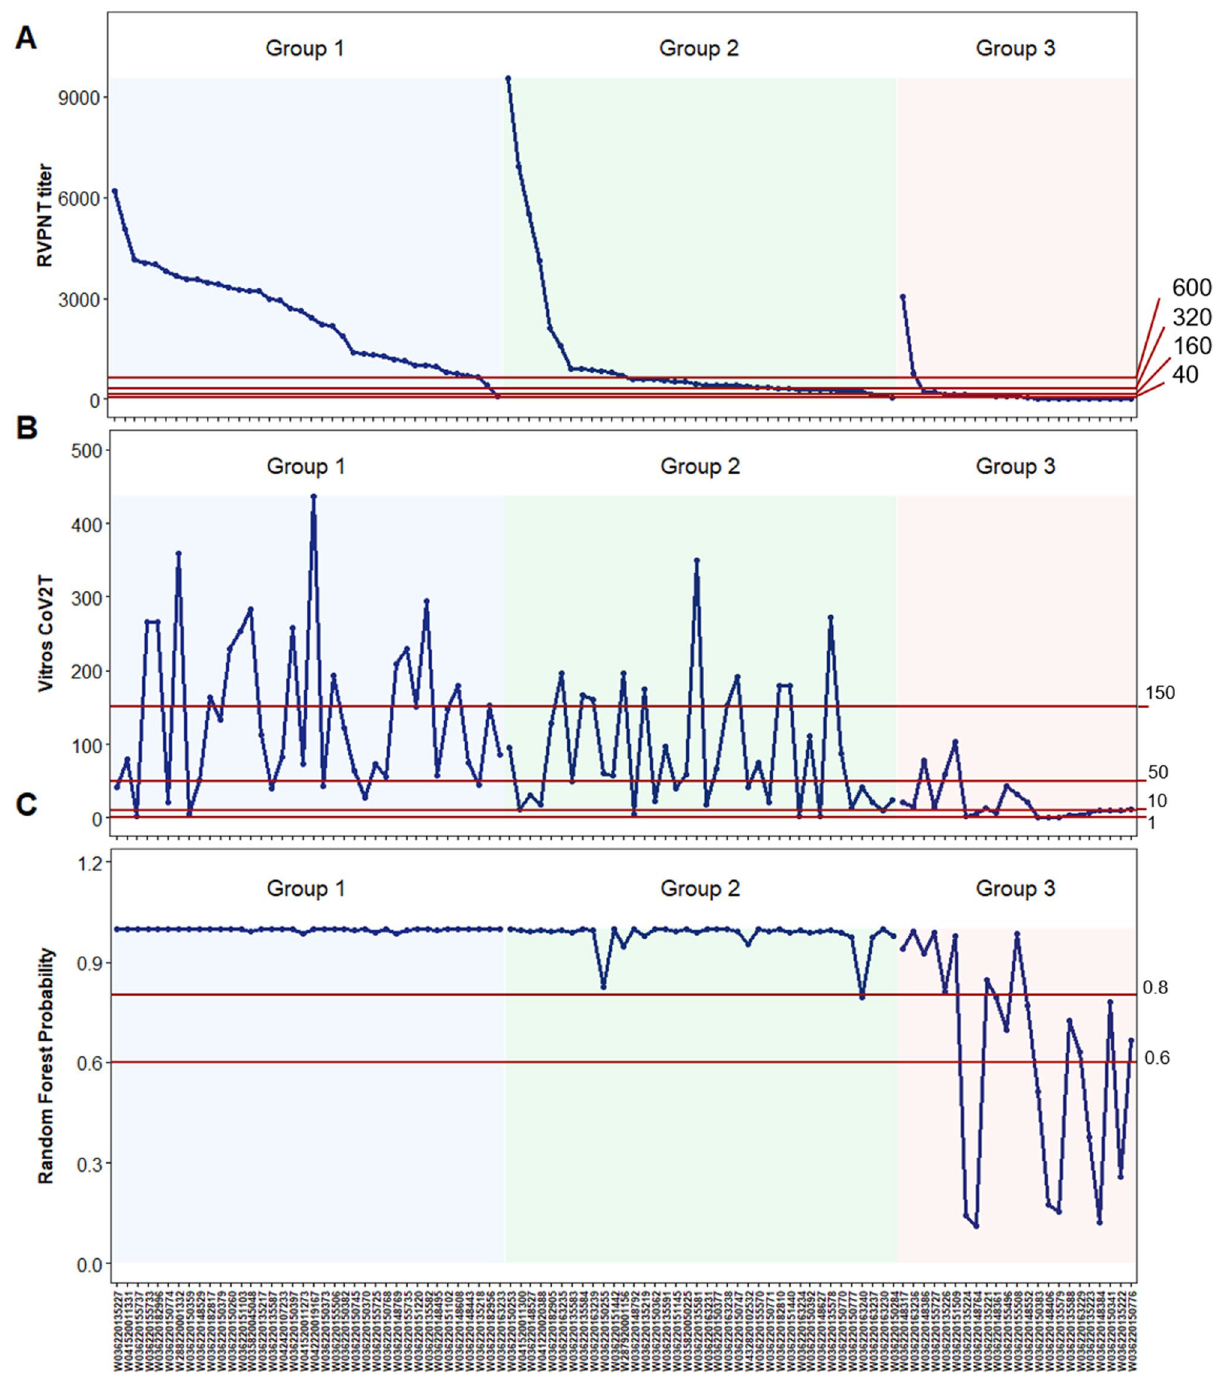
Figure 8. SARS-CoV-2 RVPNT and VITROS-CoV2T titers. In both ( A ) (RVPNT NT50 titers) and ( B ) (VITROS CoV2T S/C titers), the samples were sorted by their cluster classification and the RVPNT titers. The red, horizontal lines represent different cutoffs being, for RVPNT 1:40; 1:160; 1:320 and 1:640; for VITROS CoV2T S/C > 1, 10, 50 and 150 and for the random forest prediction probability 0.6 and 0.8. This figure was generated using the R programing language, version 4.0.2 (https:// www.r- proje ct.